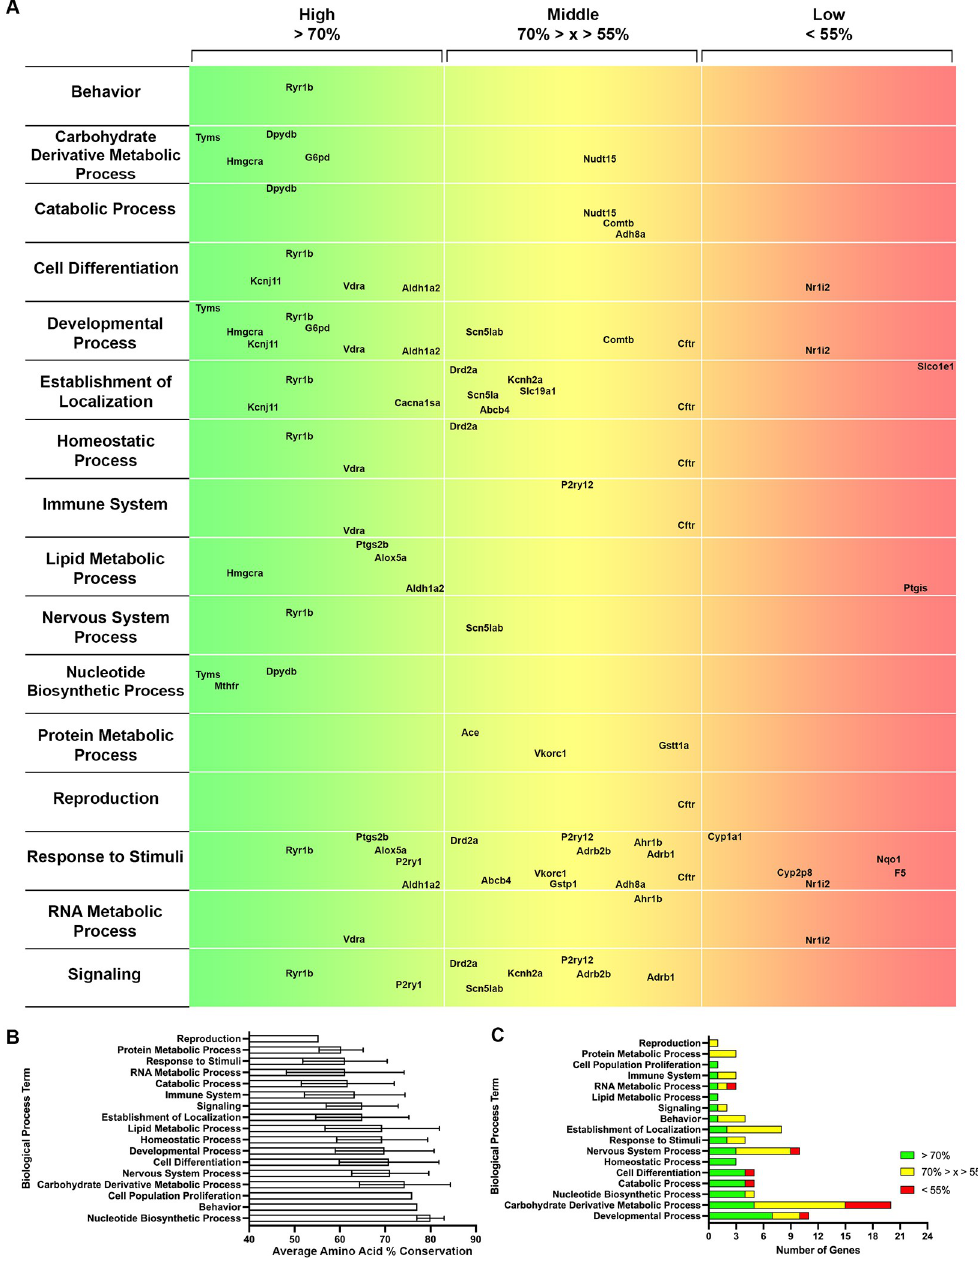
Fig 5. Gene ontology analysis for biological processes of tiered pharmacogenes. A. A map with the Biological Process terms listed (left), amino acid sequence conservation in 3 groups: > 70% = High (green to yellow, left to right), 70% > x > 55% = Middle (yellow to orange, left to right), and < 55% = Low (orange to red, left to right). The genes are placed within the respective horizontal location based on their % conservation. B. Average amino acid conservation for each Biological Process term +/- SD. C. The number of pharmacogenes in each category (High = green, Middle = yellow, Low = red) for each Biological Process term.